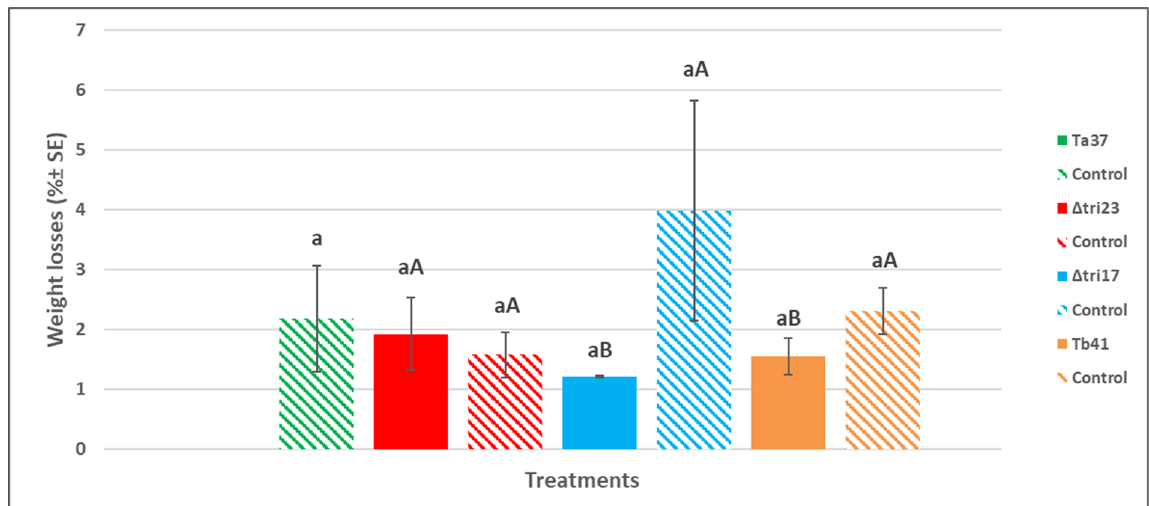
Figure 3. Weight losses (% ± SE) of treated beans (sprayed with Trichoderma strains) and their controls (sprayed with distilled water). Different lowercase letters indicate significant differences among treatments ( Trichoderma strains on the one hand, and controls on the other hand) ( p ≤ 0.05), LSD test at 0.05. Different capital letters indicate significant differences between treated beans with Trichoderma strains and their controls ( p ≤ 0.05). Data obtained from the weight loss of 80 beans.